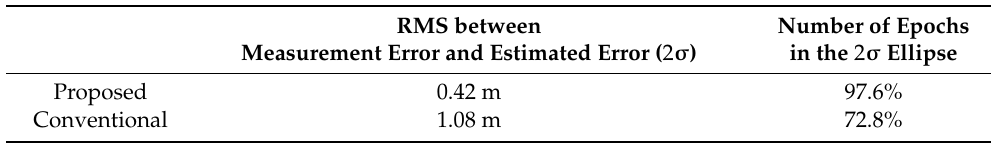
Sensors 2019 , 19 ,